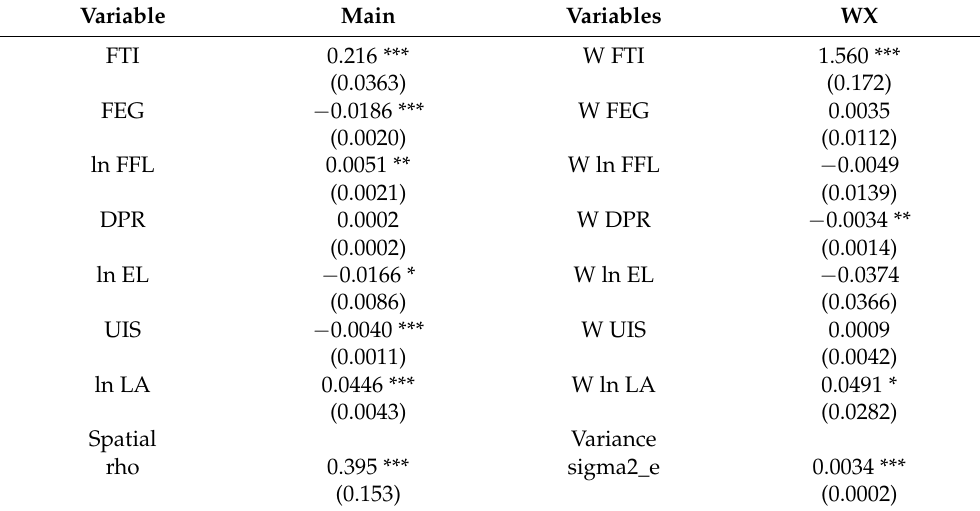
Table 8. Results of robustness checks from 2008–2020. Variable Main Variables WX